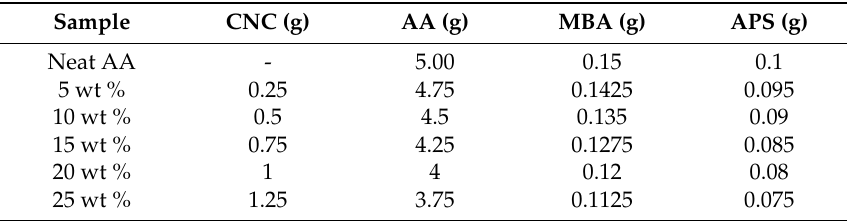
Table 2. Hydrogel